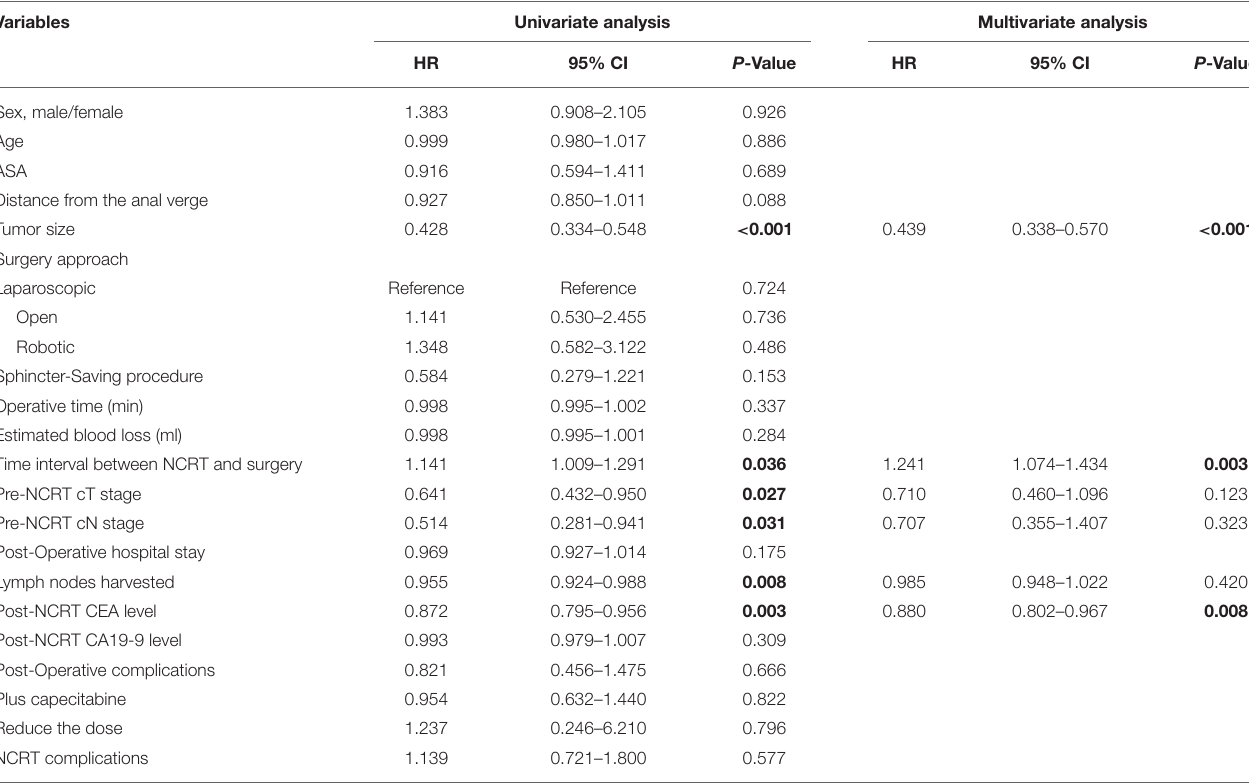
curve ( Figure 3C ) showed good accordance between predicted and observed probabilities of